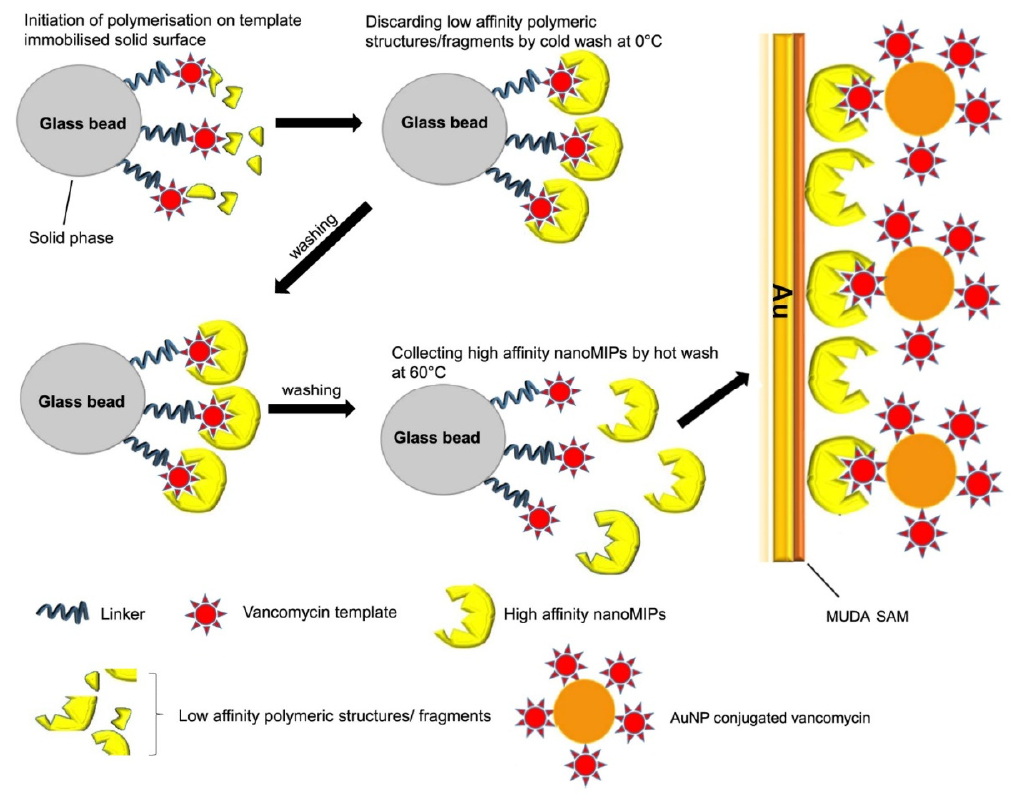
Figure 5. Schematics of the preparation of vancomycin nanoMIPs and their integration on SPR sensors for amplified vancomycin detection, following Au surface functionalisation with 11-mercaptoundecanoic acid self-assembled monolayer. Reprinted with permission from [44]. Copyright 2018 Elsevier.